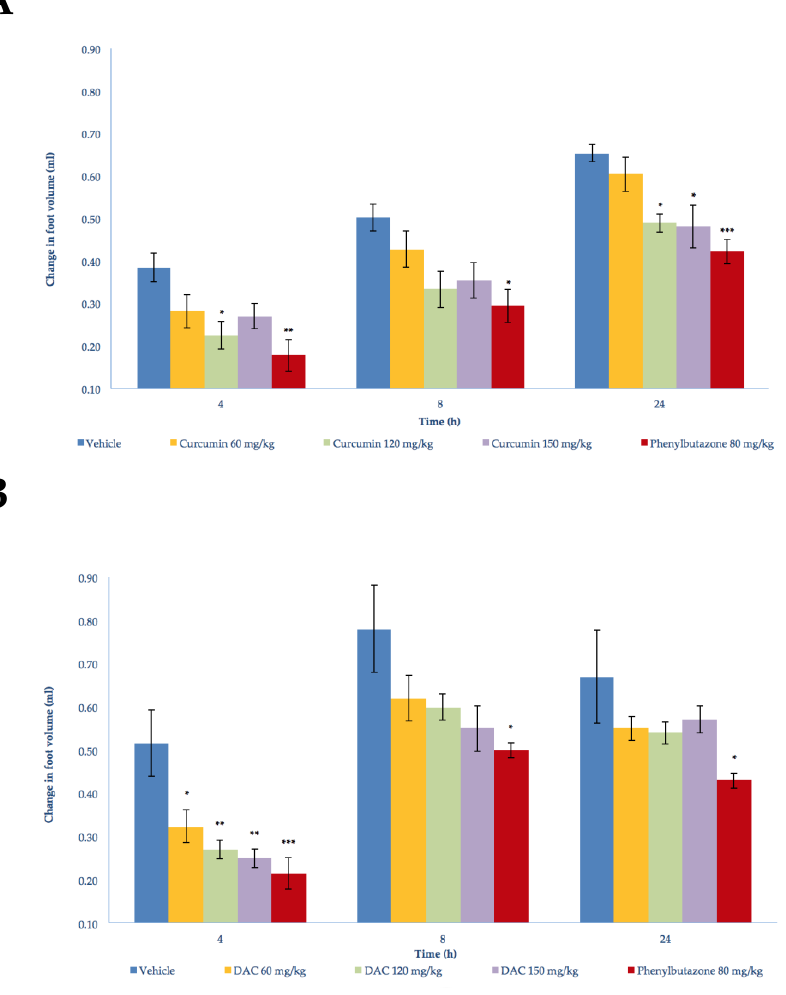
Figure 1. Acute effect of the oral administration of phenylbutazone (80 mg/kg), ( A ) curcumin, and ( B ) diacetylcurcumin (DAC) (60, 120, and 150 mg/kg) on the edema produced by intradermal injection of Freund’s complete adjuvant into the footpad of right rear limbs of Wistar rats. Each bar represents the mean ± SEM ( n = 5). ANOVA followed by Tukey’s test. p < 0.05, 0.01 and 0.001 (*, ** and *** respectively).